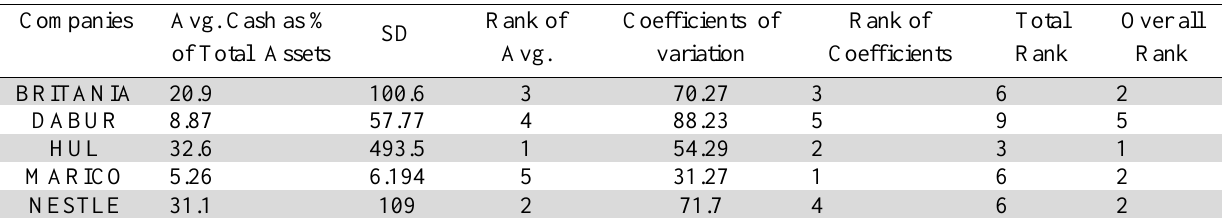
Ranking on the basis of Average and Consistency of Average Cash Holding Of the Selected Companies from FMCG Sector